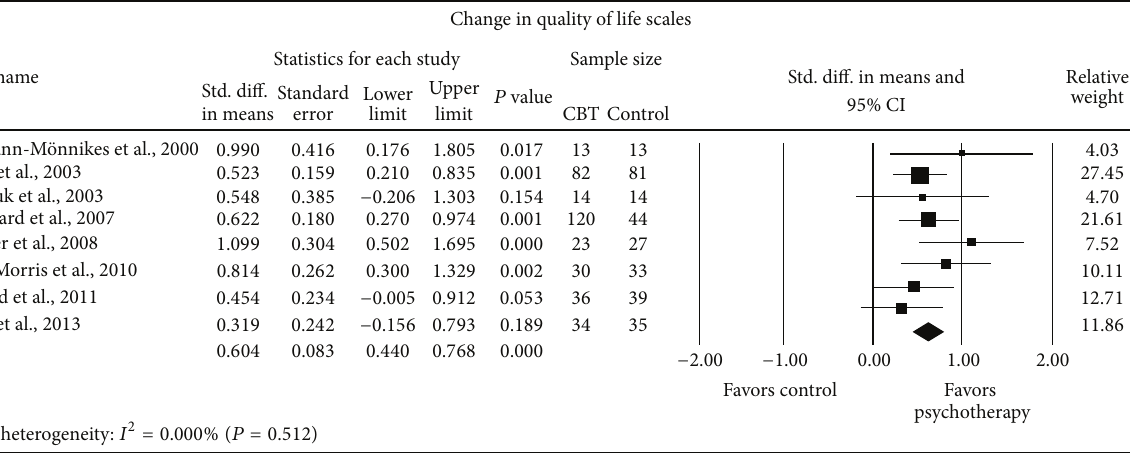
Figure 3: Forest plot for quality of life scales in RCTs of psychotherapy (PT) versus